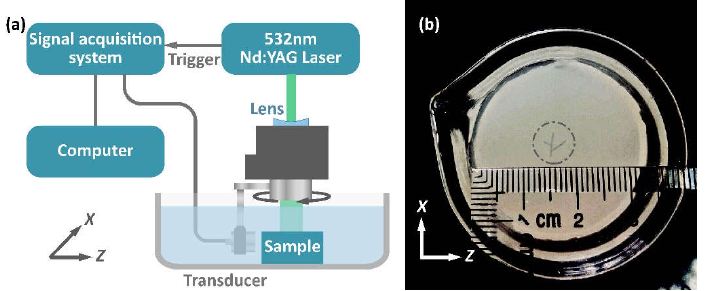
Figure 4. PA imaging of a vessel-shaped source experiment. ( a ) Schematic diagram of the PA imaging experimental setup. ( b ) Photo of the sample.